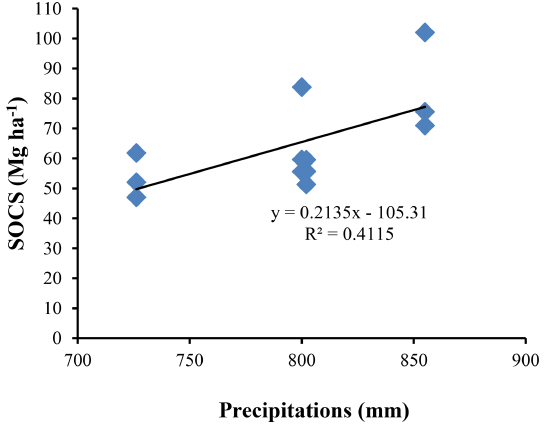
Figure 5. Plots of the soil organic carbon stock (SOCS) versus pre- cipitation in the study